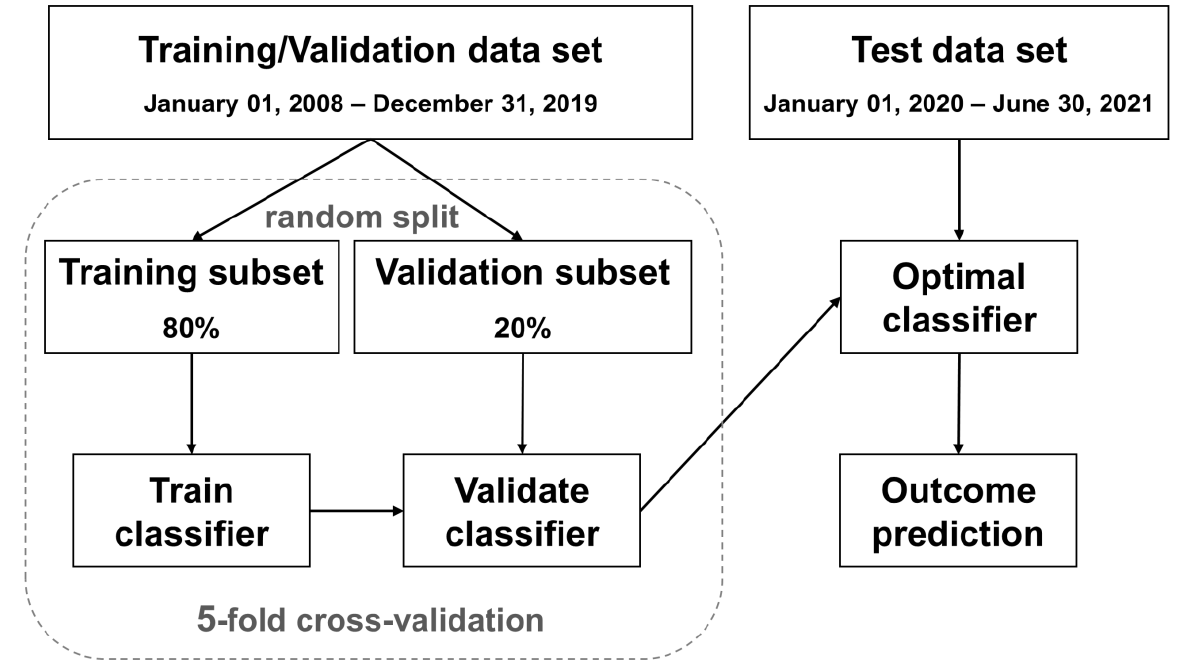
Figure 2. The architecture of our prediction models.